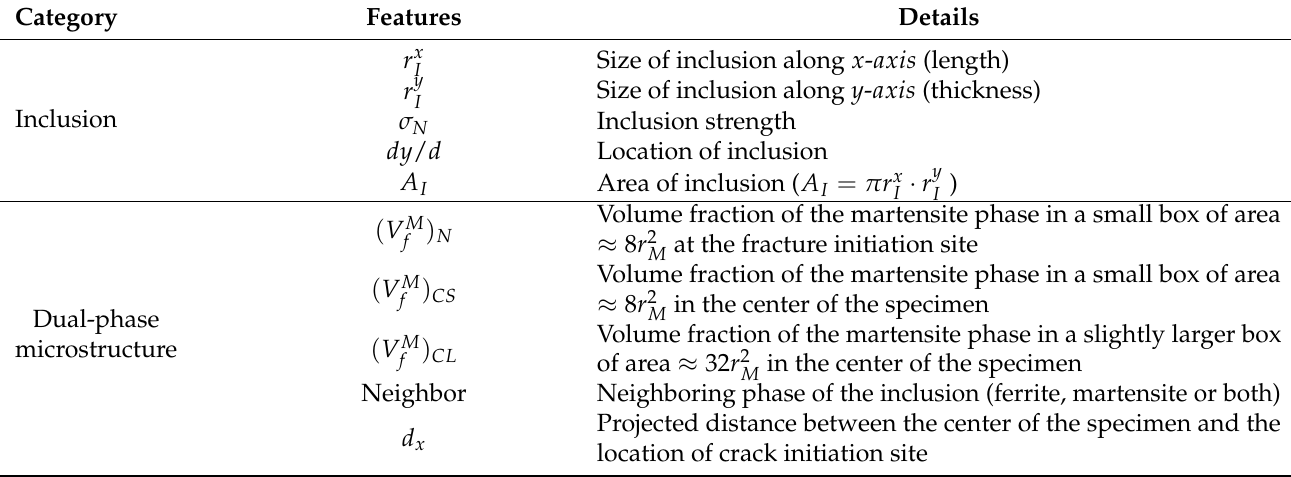
Table 2. All the possible features identified from microstructure-based finite element calculations that may affect the bendability of the dual-phase steel with (in this work) and without (in ref. [24]) an inclusion.